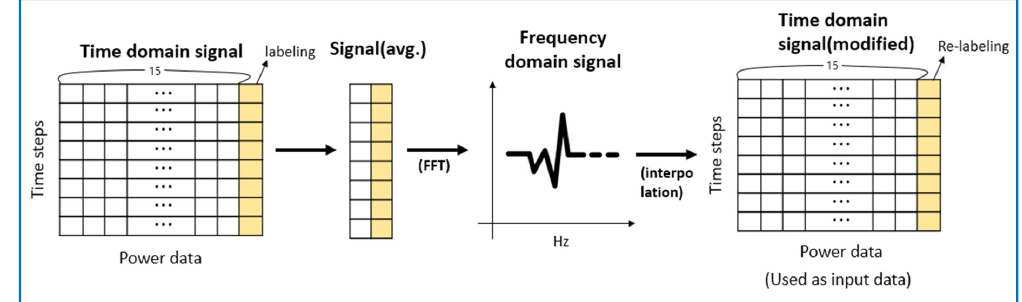
Figure 5. Process of data pre-processing.